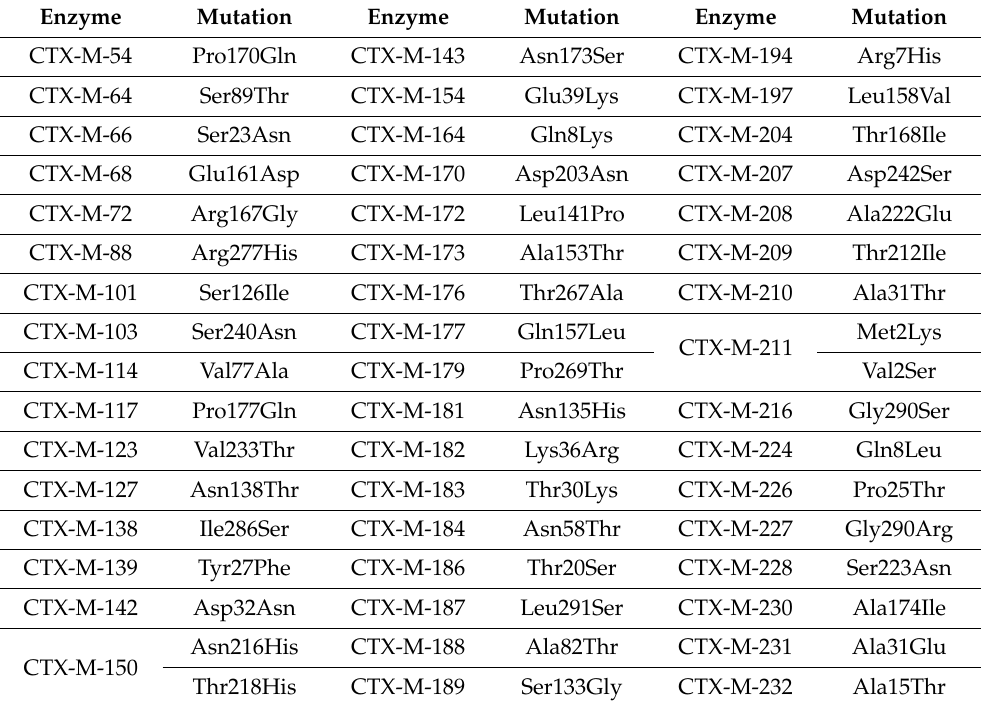
Table 2. List of variant-specific mutations among CTX-M-1 cluster enzymes.